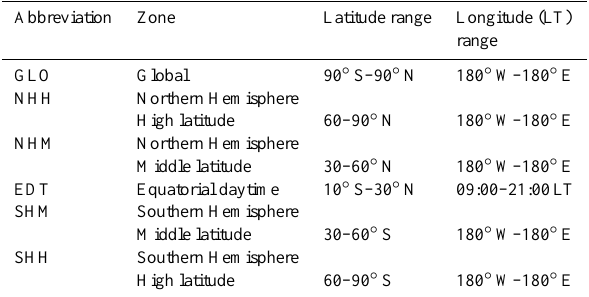
Table 1. Geographic zone